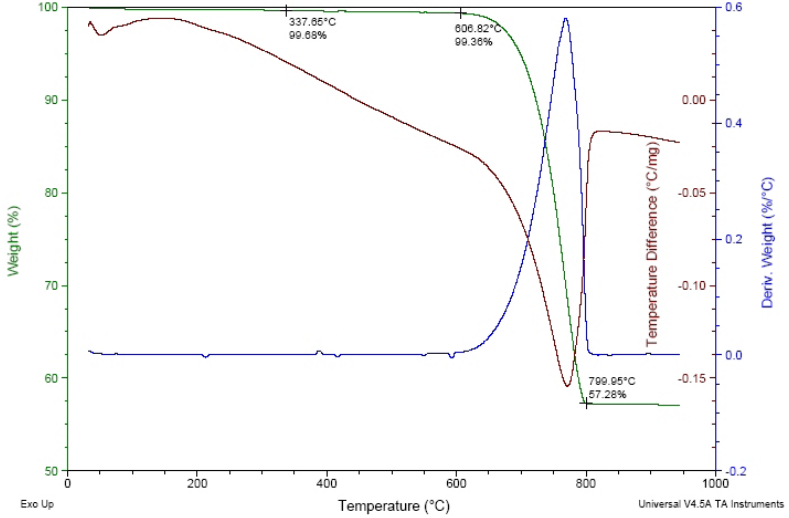
Figure 3. DSC-TGA for calcium carbonate precipitate